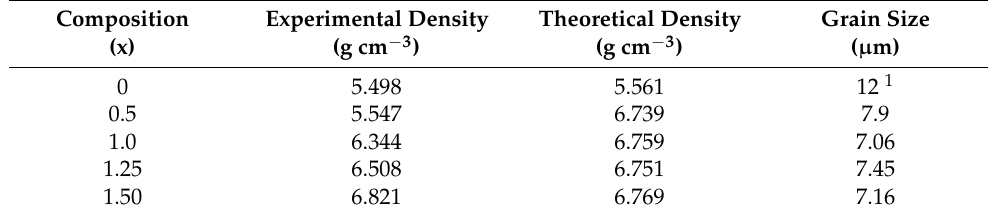
Figure 1. Rietveld refinement patterns for different W-doped samples at room temperature; ( a ) 0.50 W; ( b ) 1.0 W; ( c ) 1.25 W; ( d ) 1.5 W. Table 1. Experimental and theoretical densities, as determined by Rietveld refinement, for different W-substituted samples. The grain size variation is also shown for different W-substituted